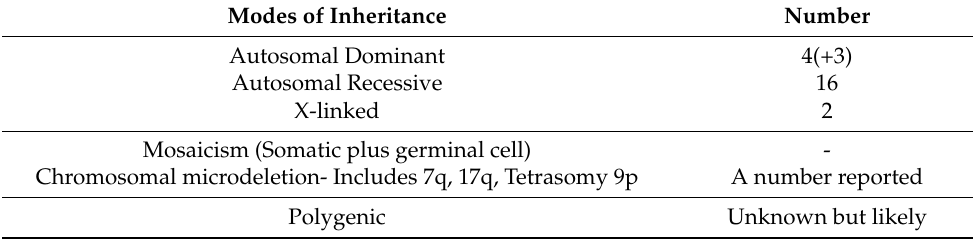
Table 2. Patterns of Inheritance in Osteogenesis Imperfecta.